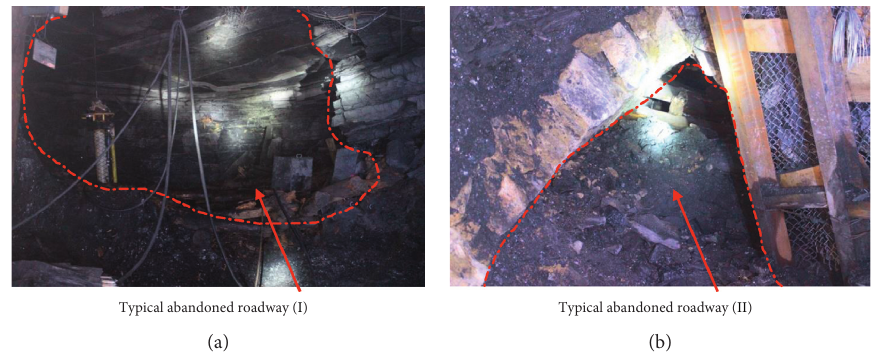
Figure 2: The in situ investigation photos for abandoned roadways. (a) Typical abandoned roadway (I); (b) typical abandoned roadway